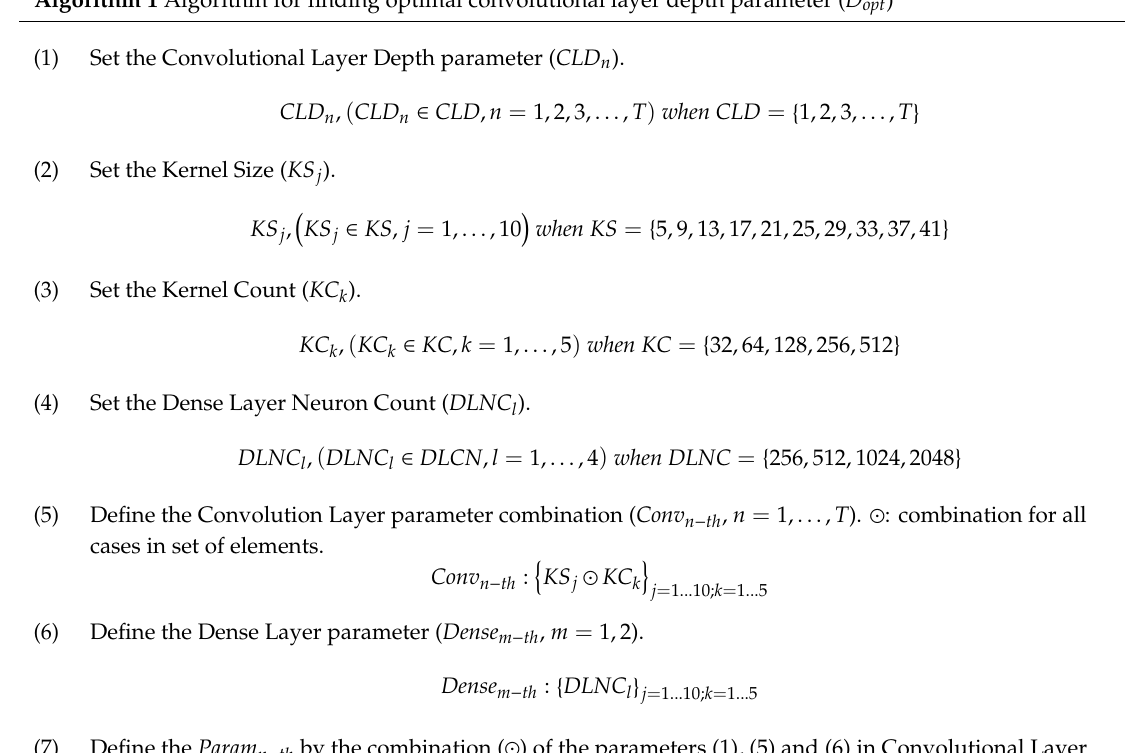
Algorithm 1 Algorithm for finding optimal convolutional layer depth parameter ( D opt